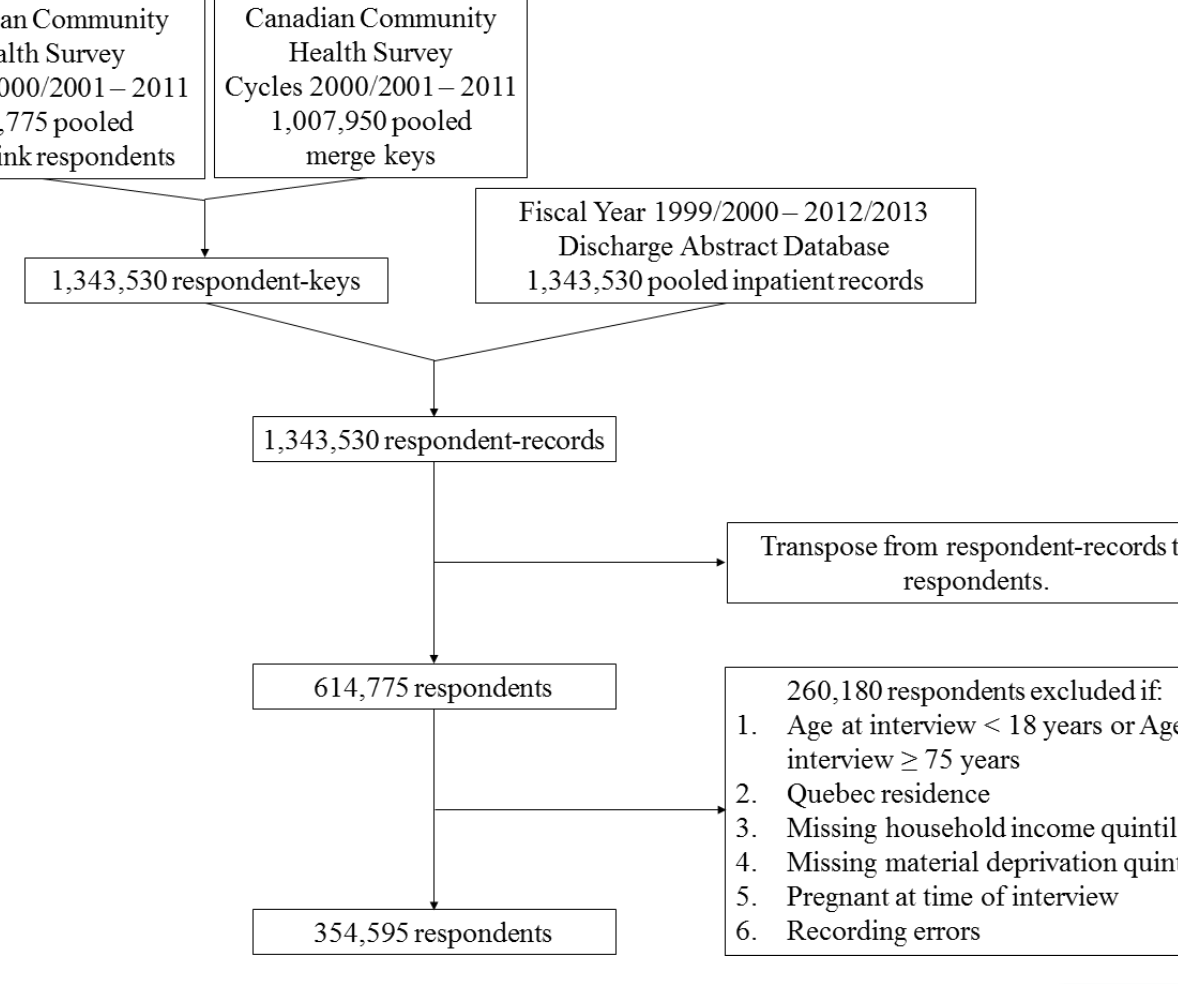
Figure 1: Study flow